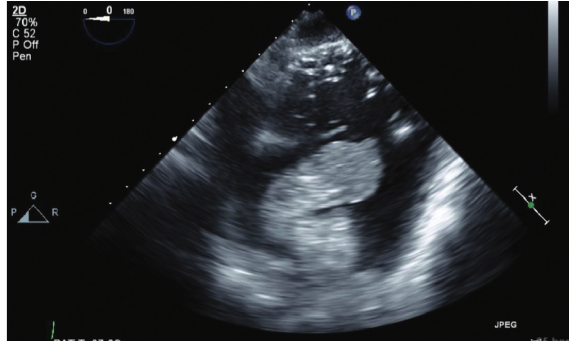
Figure 3: TEE-modified transgastric right ventricle inflow view: large hyperechoic lobulated mass across the tricuspid valve and occupying the body of the right